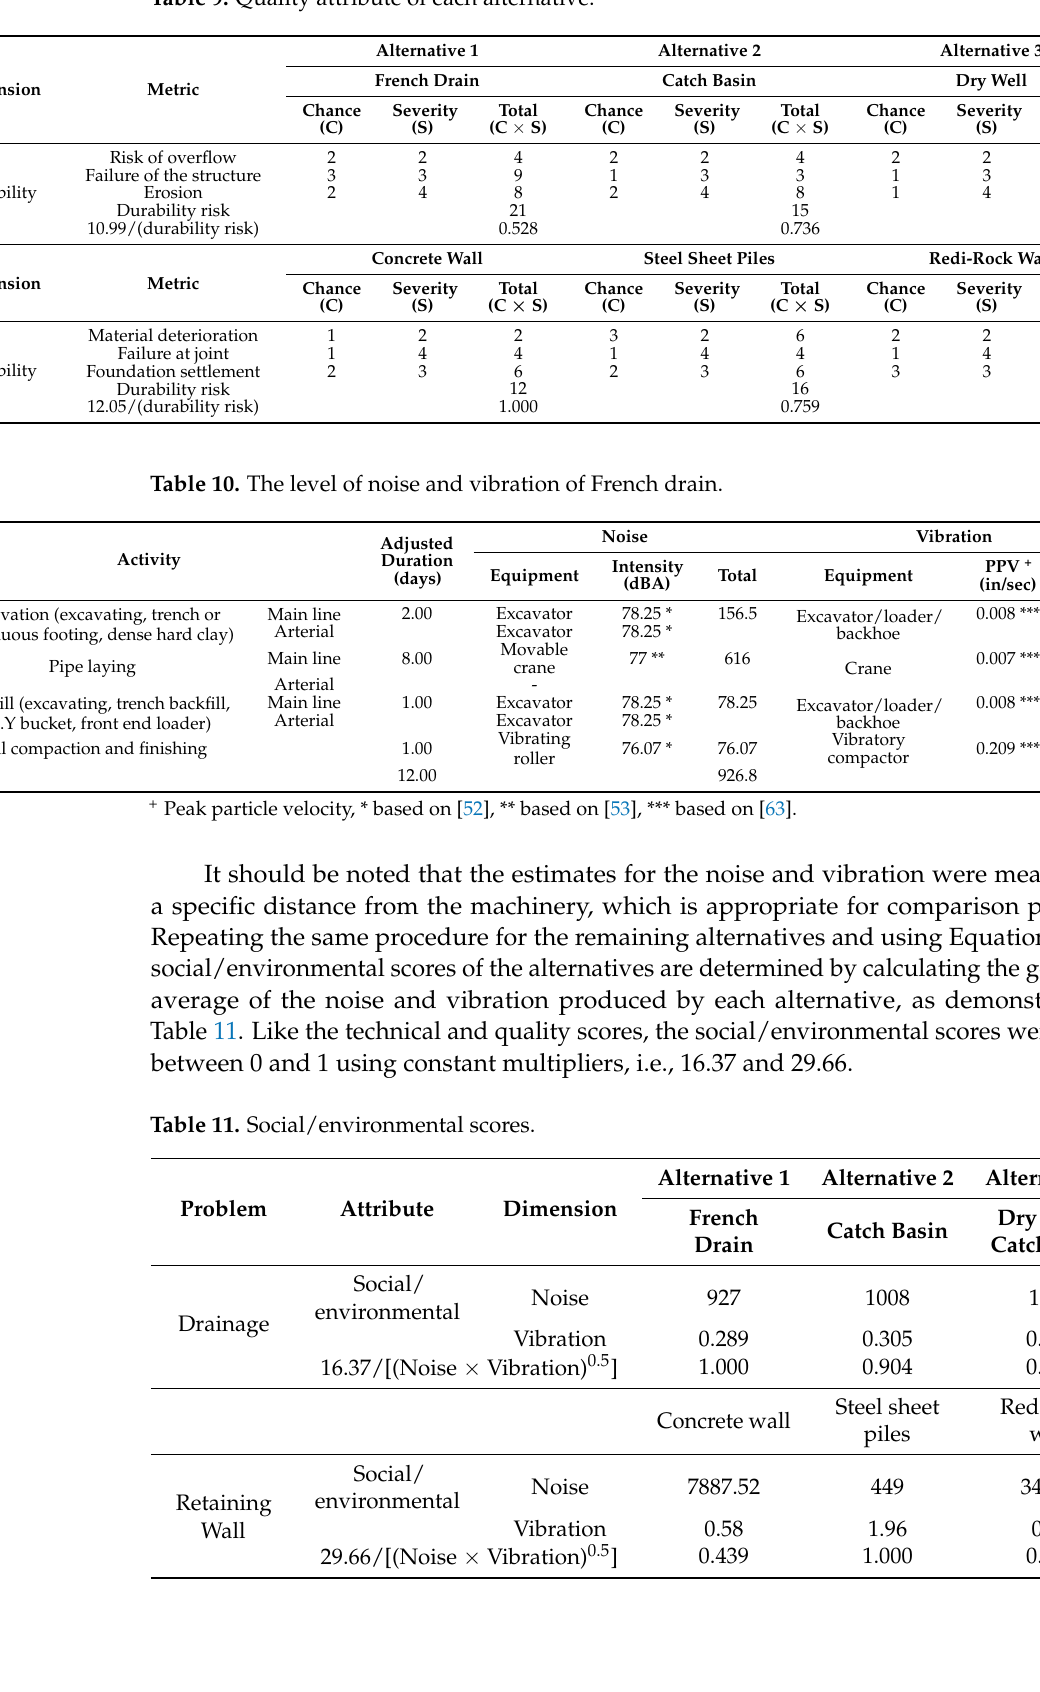
Table 9. Quality attribute of each alternative.